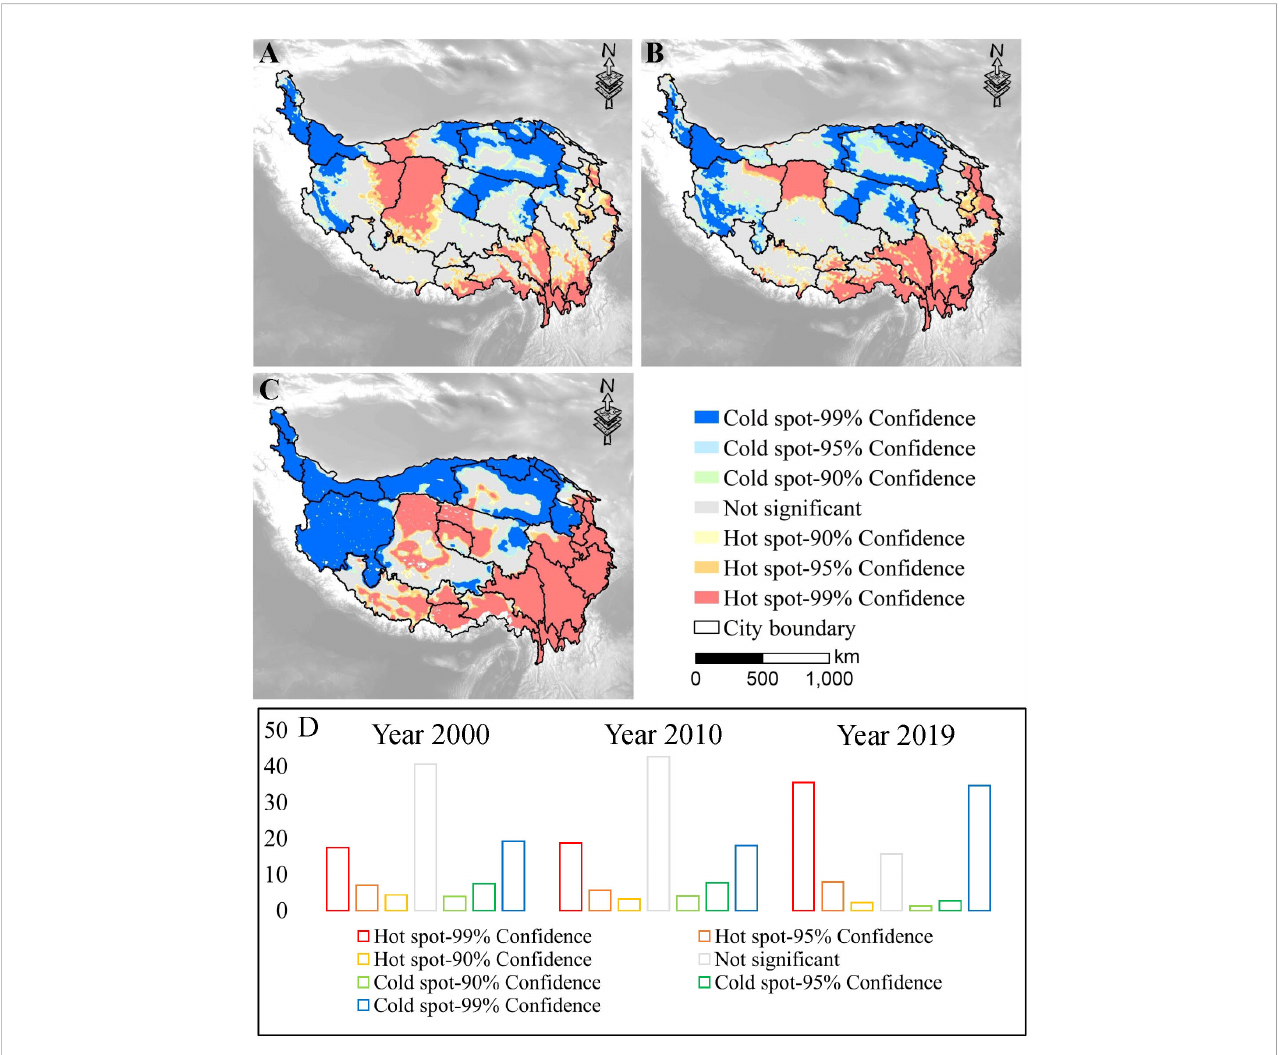
FIGURE 3 Gi* scores of pressures in 2000 (A) , 2010 (B) , 2019 (C) and the proportions (D)